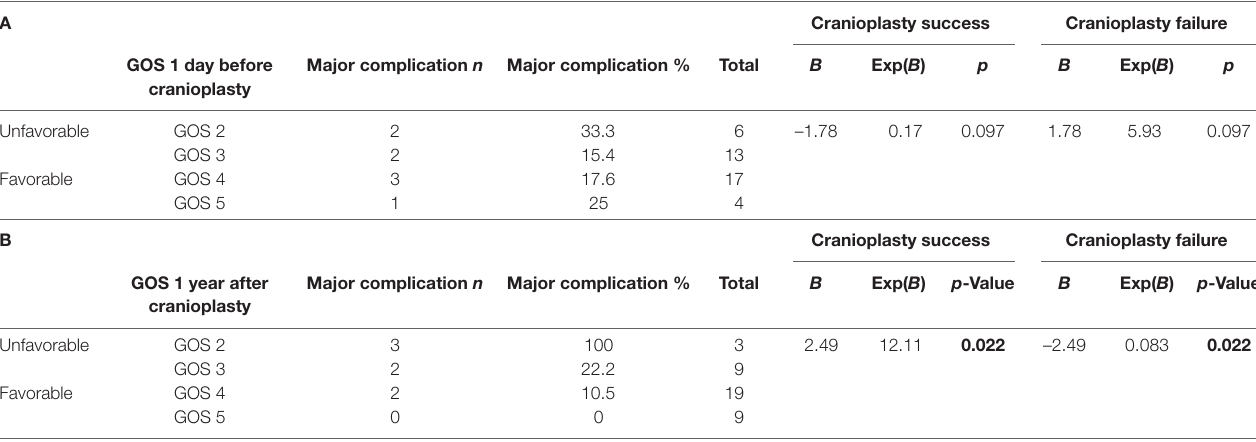
Table 4 . No cases of death occurred during the follow-up